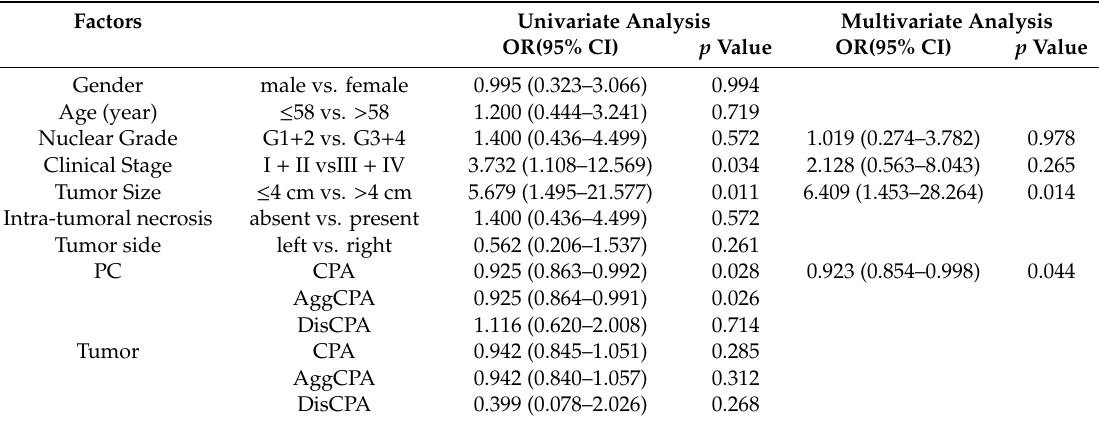
Table 2. Logistic regression analysis for pseudo-capsule